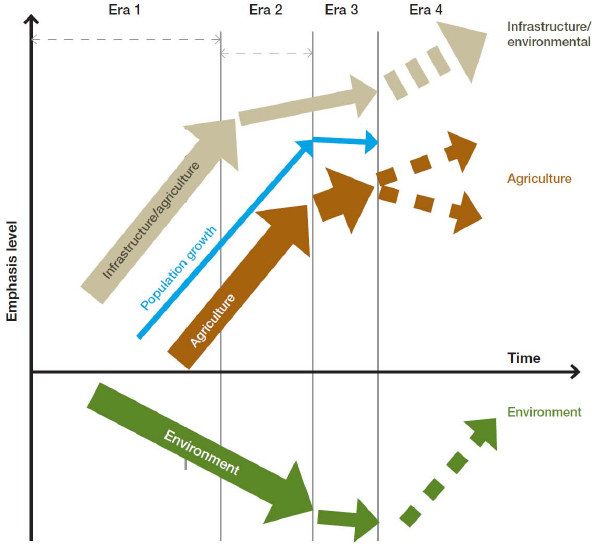
Fig. 3. The change in infrastructure, the environment, population and agriculture production in the Murrumbidgee through four eras: Era 1 (1900–1960) – the development of irrigation and associated infrastructure; Era 2 (1960–1990) – agradual appreciation of real- ization of environmental degradation; Era 3 (1990–2007) – aware- ness of broader environmental impacts and a focus on consensus strategies and policies to achieve integrated and sustainable man- agement; Era 4 (2007–present) – accepting the failure of the consen- sus model, with the emergence of a directed Commonwealth Gov- ernment strategy to achieve environmental sustainable outcomes. Emphasis level used in relation to the vertical axis refers to the de- gree of increase in the parameters described in the figure (agricul- ture, population, infrastructure, and